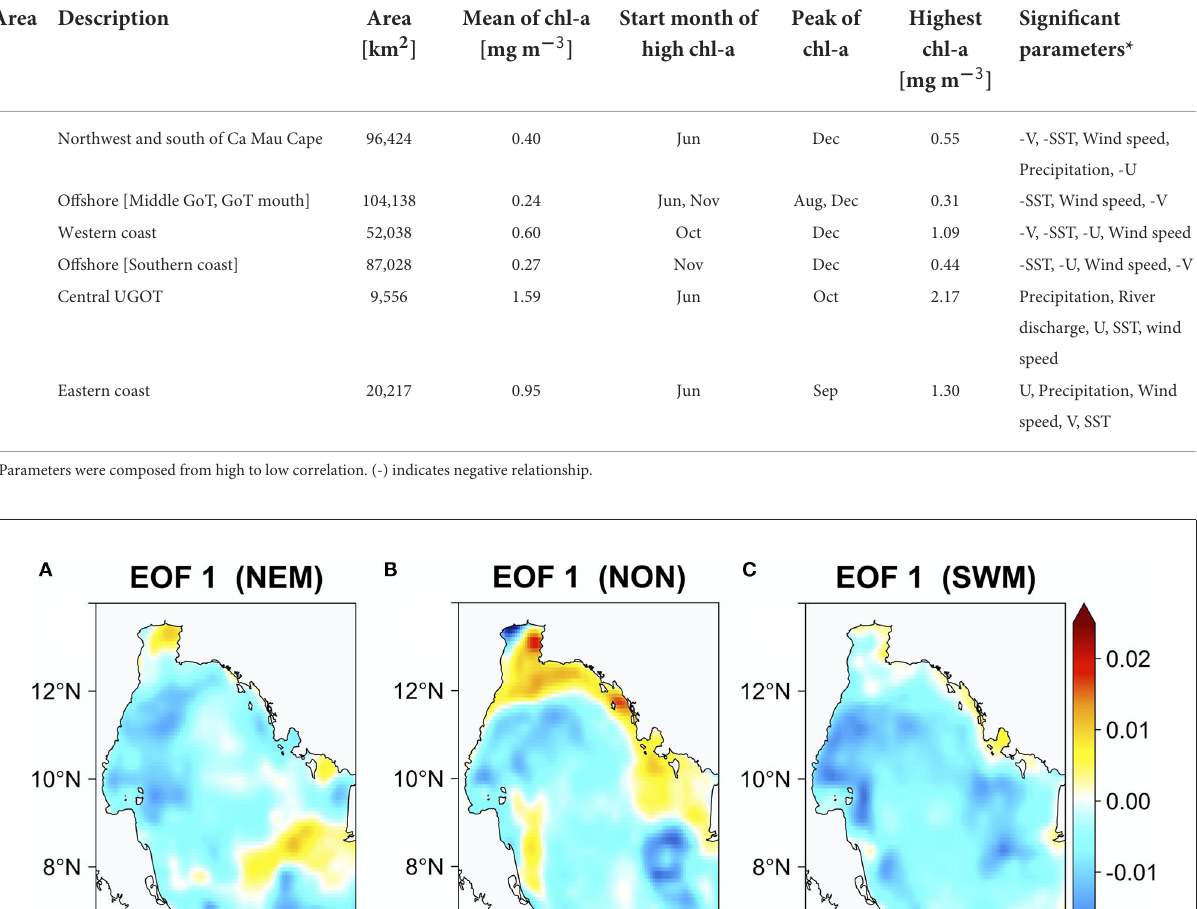
FIGURE6 The first EOF mode of chl-a in each season (A–C) and PCs (D–F) .